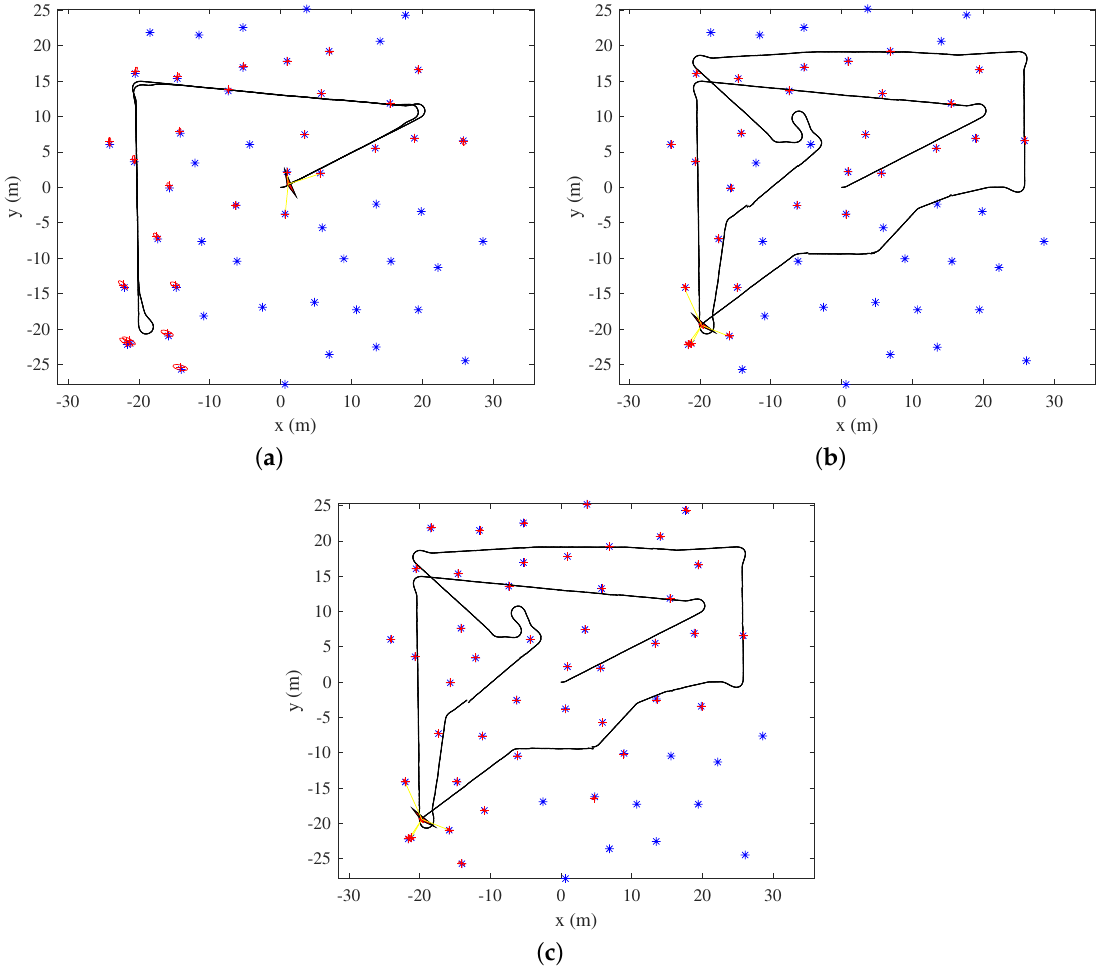
Figure 9. The simulation results of three revisiting methods: ( a ) Backtracking. ( b ) The covariance TSP fixed algorithm that restricts adding new landmarks during revisiting. ( c ) The covariance TSP